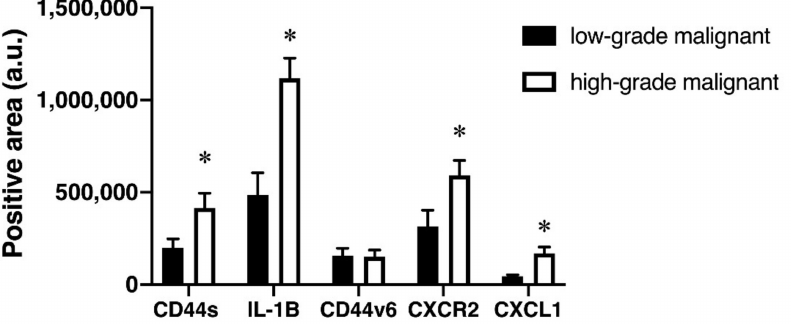
Figure 5. The expression of CD44s, IL-1 β , CD44v6, CXCR2, and CXCL1 in different grades of malignant salivary gland tumors. * p < 0.05 vs. low-grade malignant salivary gland